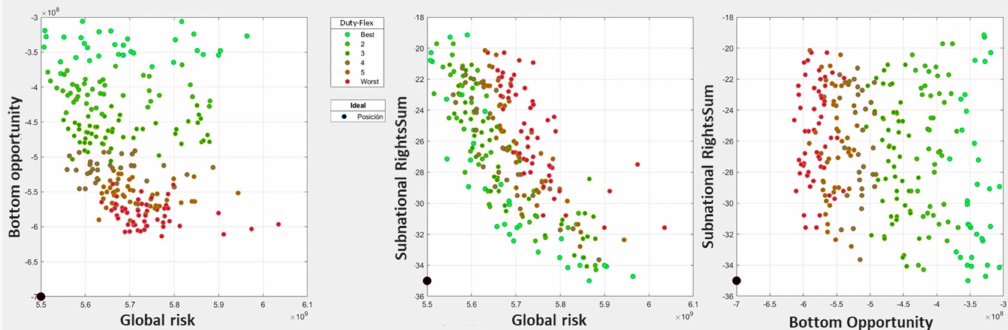
Figure 9. Results of the generation of decentralization solutions, trade-o ff s between global risk, opportunity at local scale, summation of sub-national rights, and flexibility in duties for the economic cost